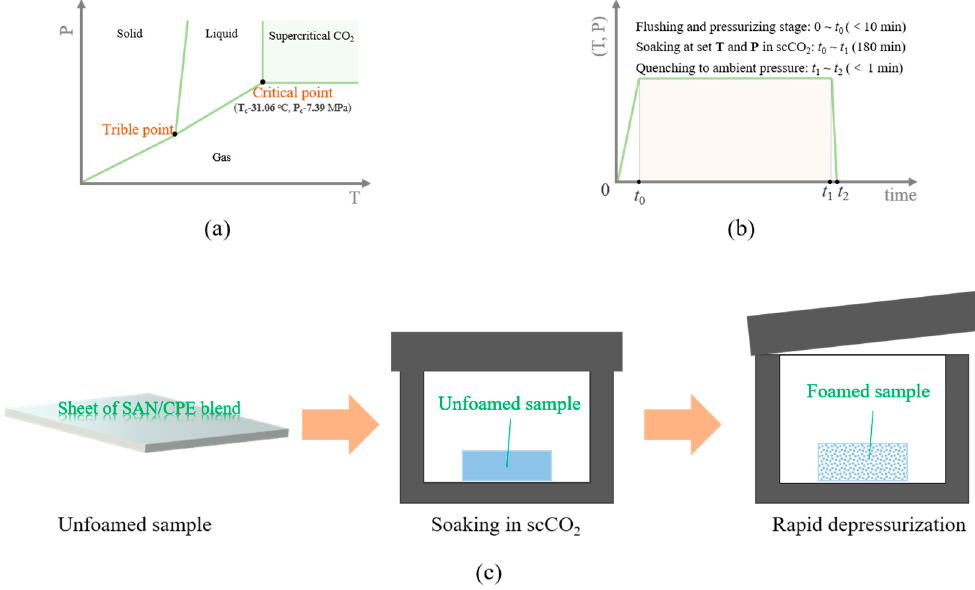
Figure 1. ( a ) Pressure-temperature phase diagram of supercritical CO 2 ; ( b ) Schematic diagram of sample treatment and foaming process with supercritical fluid; ( c ) Illustration of one-step foaming process with supercritical carbon dioxide (scCO 2 ) as a physical blowing agent.